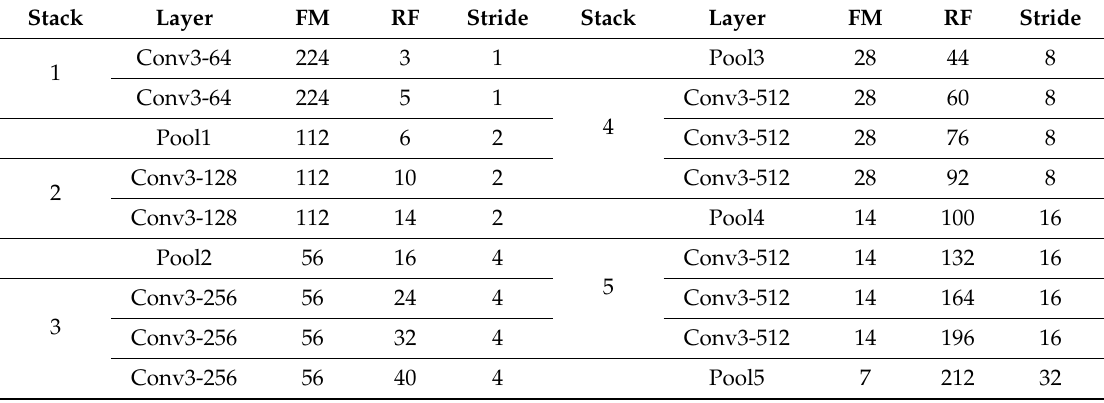
Table 2. Values of the feature map (FM) and receptive field (RF) in each layer of VGG-16.